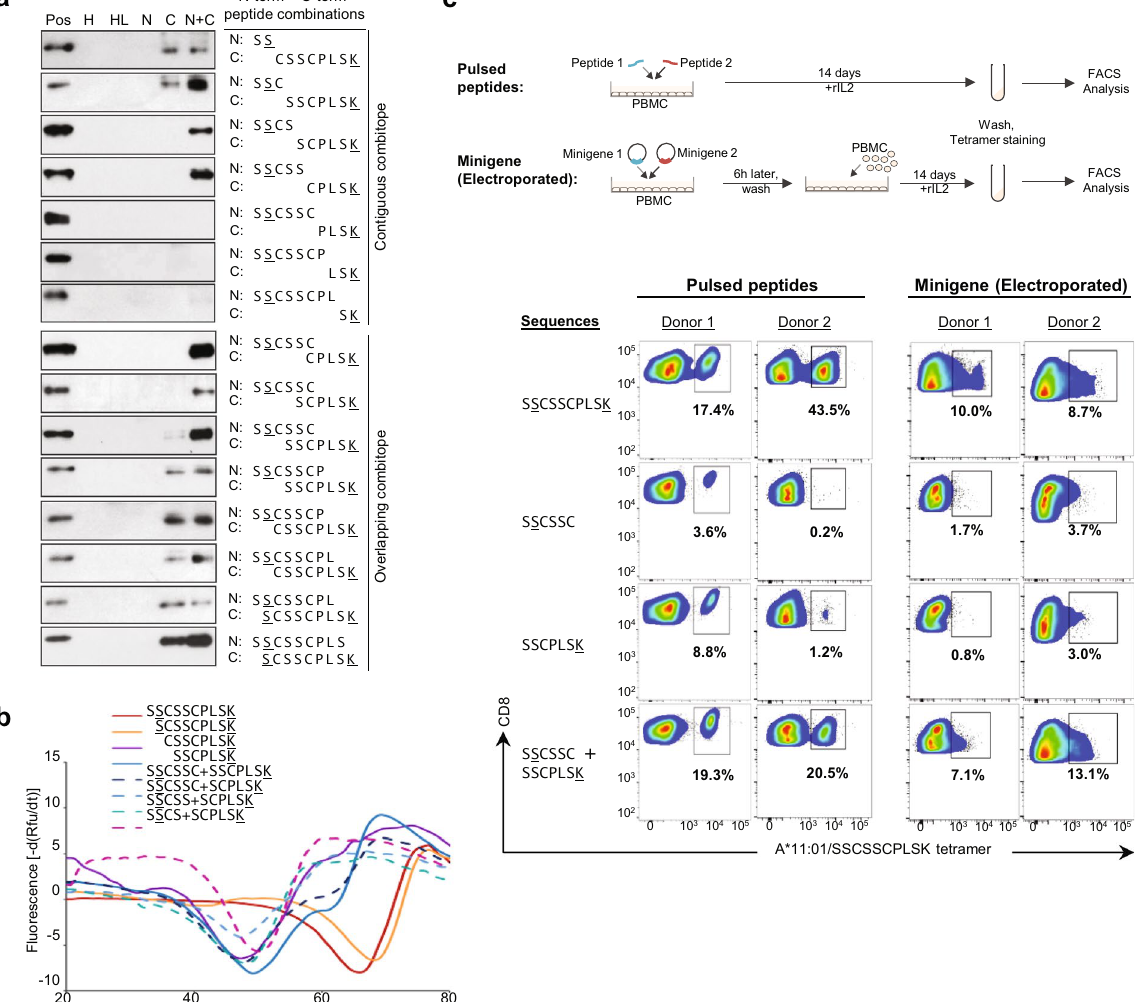
Figure 4. Stabilization of pHLA complexes by combinational non-canonical short peptides. ( a ) Stabilization of pHLA complexes formed by HLA-A * 11:01 and β 2 m with combination epitopes (combitopes) of short C-terminal (C) and N-terminal (N) SSCSSCPLSK peptides. Refolding with both C- and N-terminal SSCSSCPLSK peptides (N + C) generates combination of contiguous peptides (Contiguous combitope) as well as combination of peptides with increasing number of overlapping amino acids (Overlapping combitope). Heavy chain (H), heavy and β 2 m light chain (HL) served as the negative controls while pHLA complex with SSCSSCPLSK (pos) served as the positive control for each western blot panel. ( b ) Real time PCR thermofluor measurement for pHLA complexes formed by HLA-A * 11:01 heavy chain and β 2 m with SSCSSCPLSK (Tm = 68.1 °C), SCSSCPLSK (Tm = 69.7 °C), CSSCPLSK (Tm = 49.4 °C), SSCPLSK (Tm = 50.0 °C), SSCSSC + SSCPLSK (Tm = 49.4 °C), SSCSSC + SCPLSK (Tm = 48.7 °C), SSCSS + SCPLSK (Tm = 49.7 °C) and SSCS + SCPLSK (Tm = 50.3 °C). ( c ) Workflow for 14-day PBMC cultures following peptide pulsing and minigene electroporation is shown. Truncated peptides SSCSSC and SSCPLSK were introduced in combination or singly in the form of pulsed peptides or electroporated minigenes constructs. Recall CD8 T cell responses were detected by A * 11:01/SSCSSCPLSK tetramer staining of 14-day PBMC cultures in two different HLA- A * 11:01